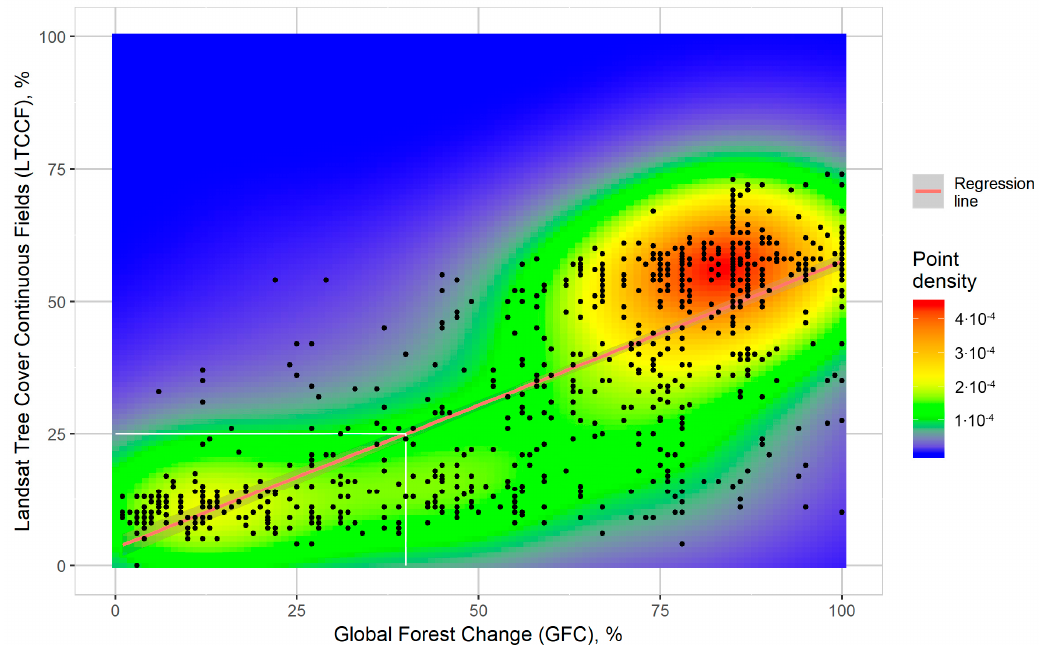
Figure 7. Scatter plot of percent tree cover estimates of GFC against LTCCF